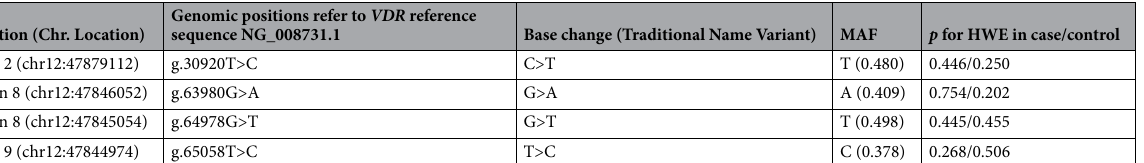
Table 5. Primary information for study of the VDR polymorphisms. Chr. Location according to the human reference sequence (GRCh38.p12), MAF minor allele frequency, HWE Hardy–Weinberg equilibrium. HWE p-value chi-square